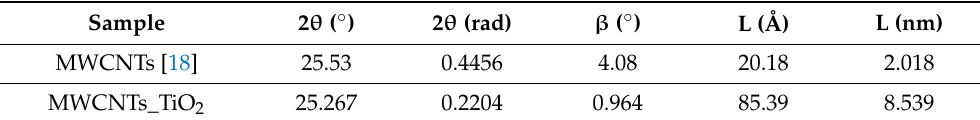
Table 2. Summary of the XRD characterisation of synthetised MWCNTs and MWCNTs_TiO 2. Sample